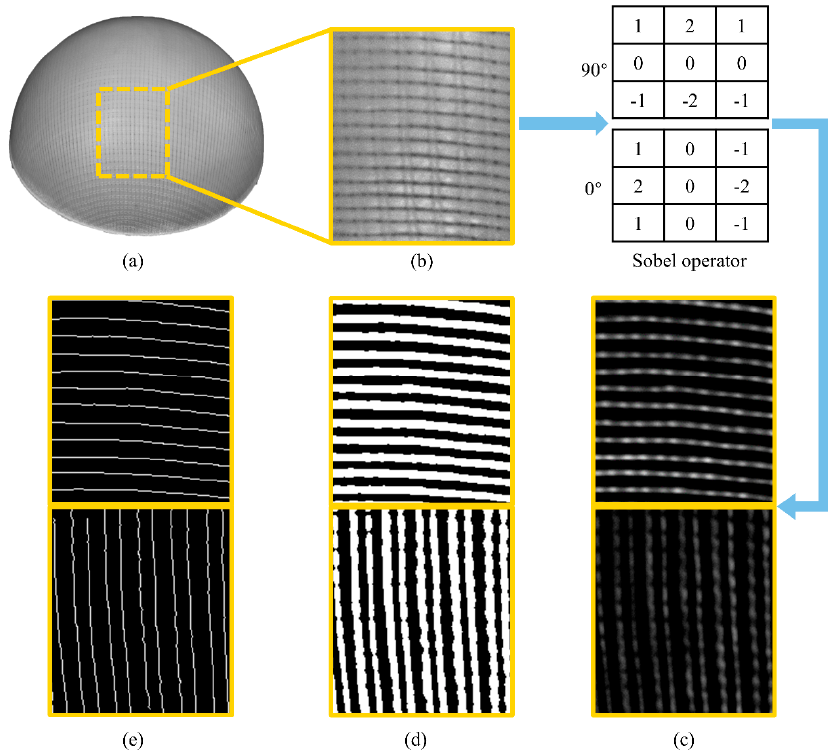
Figure 6. Image processing results: ( a ) original data; ( b ) close-up image of mean filter result; ( c ) convolution; ( d ) binarization; ( e ) thinning.